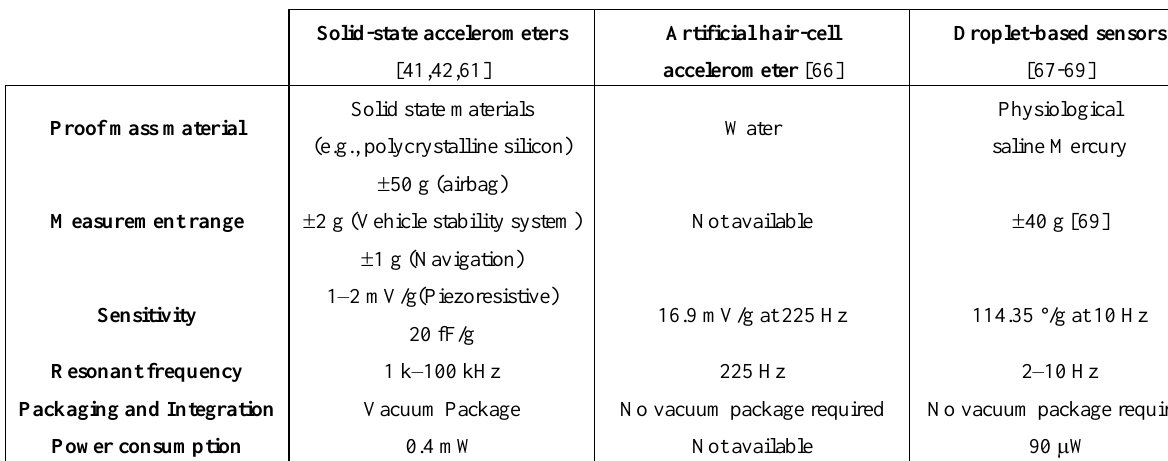
Table 1. Comparison of typical man-made inertial sensing